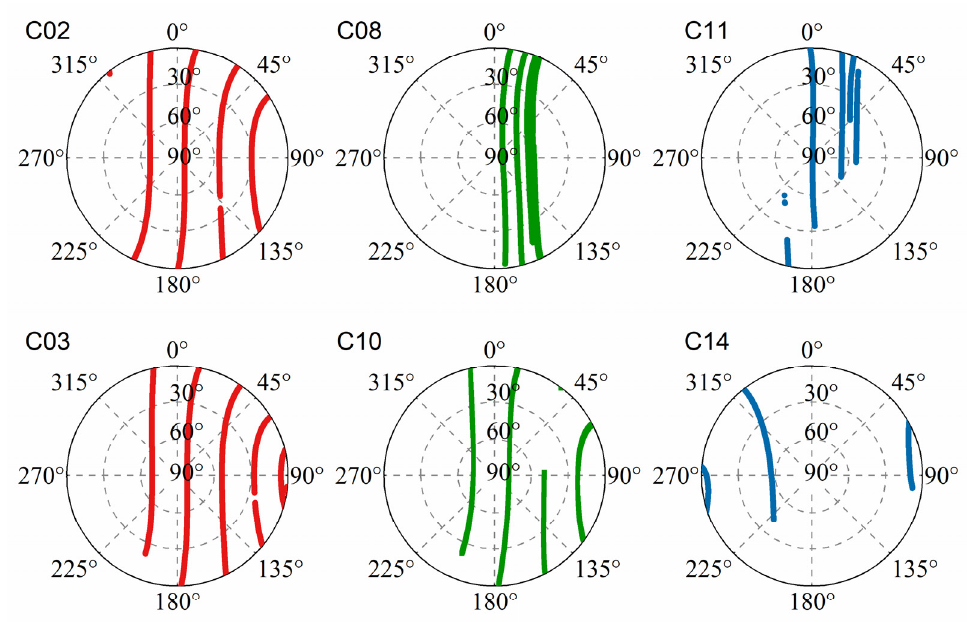
Figure 4. The sky view of the BeiDou satellites from the ARF of Luojia-1A satellite. The red, green, and blue lines represent the geostationary earth orbit (GEO), inclined geostationary (IGSO), and medium earth orbit (MEO) satellites, respectively.